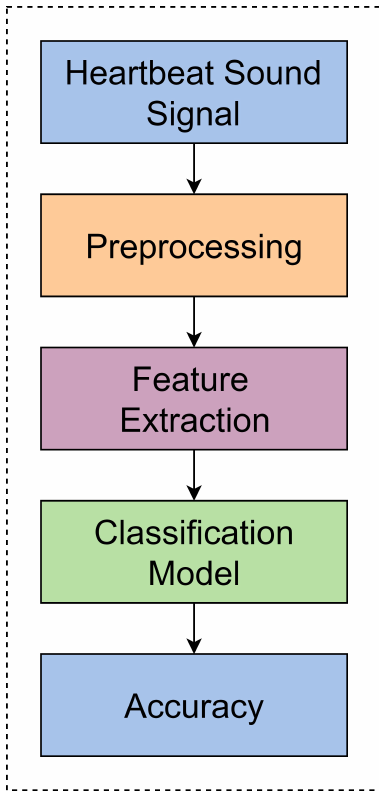
Figure 1. Architecture of this